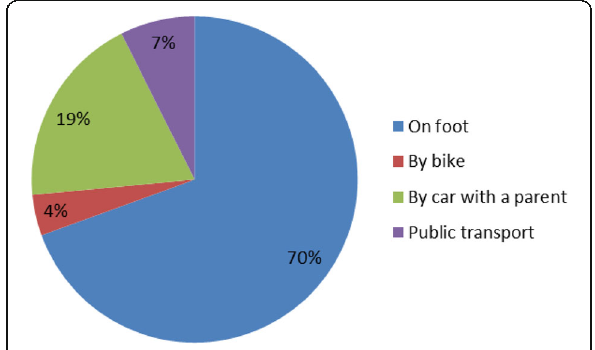
Fig. 9 The percentage division of children aged depending on the distance between home and school